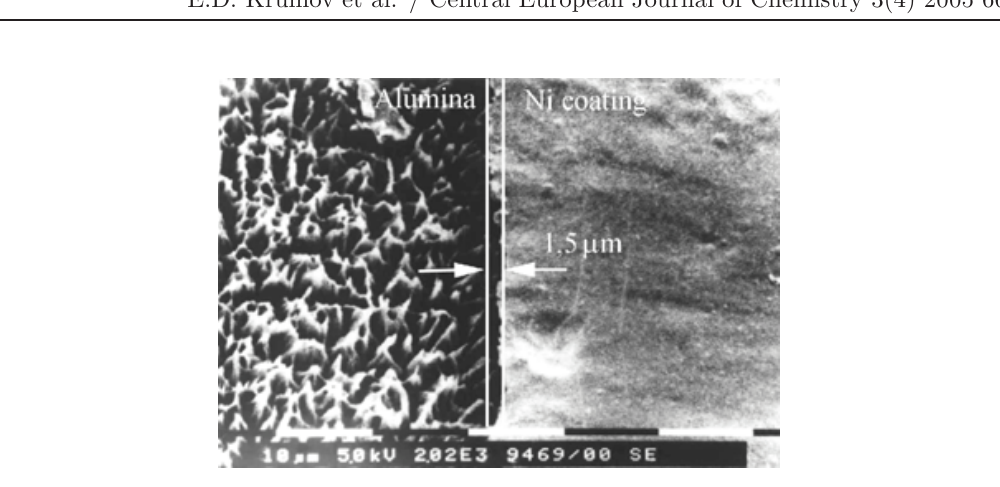
Fig. 4 SEM micrograph of the microstructured Ni/Ag/Al 2 O 3 /Al system demonstrating the edge